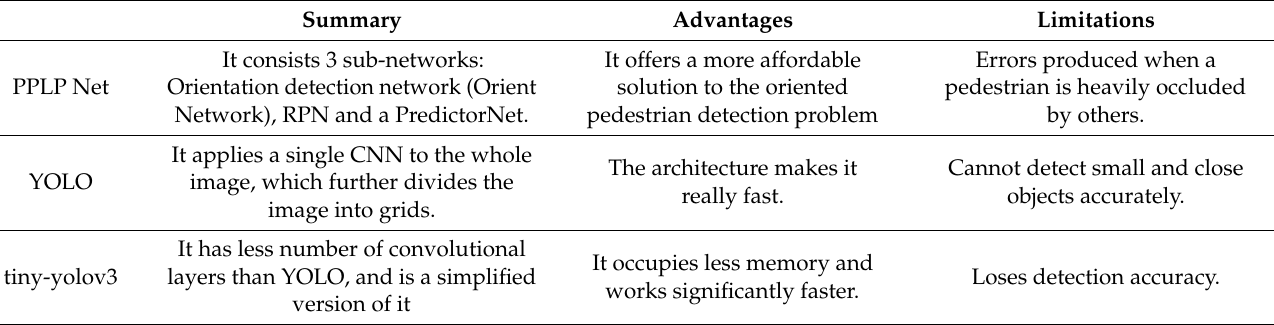
Table 4. Summary of pedestrian detection